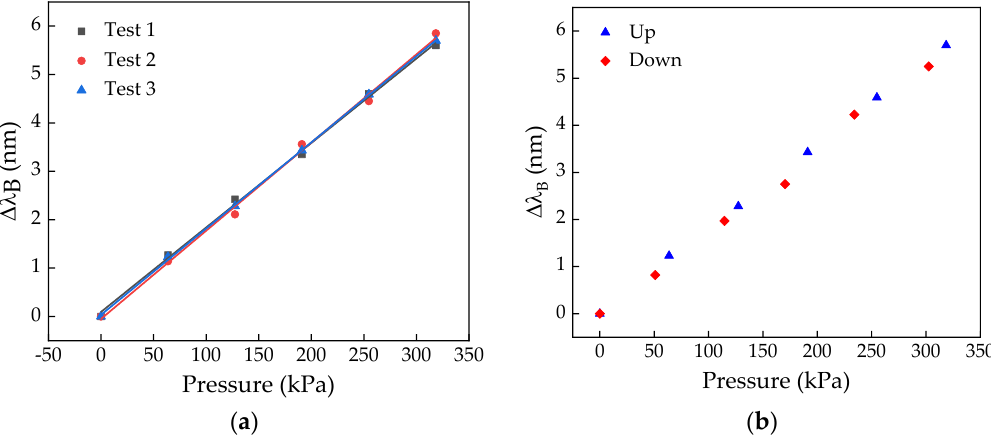
Figure 3. Results of the calibration ( a ) and hysteresis ( b ) tests for the left scapula (SL) cell.